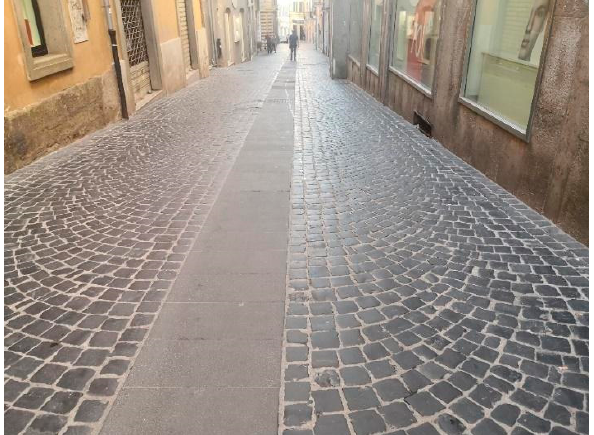
Figure 10. Typical Sampietrini Pavement in the city of Velletri.